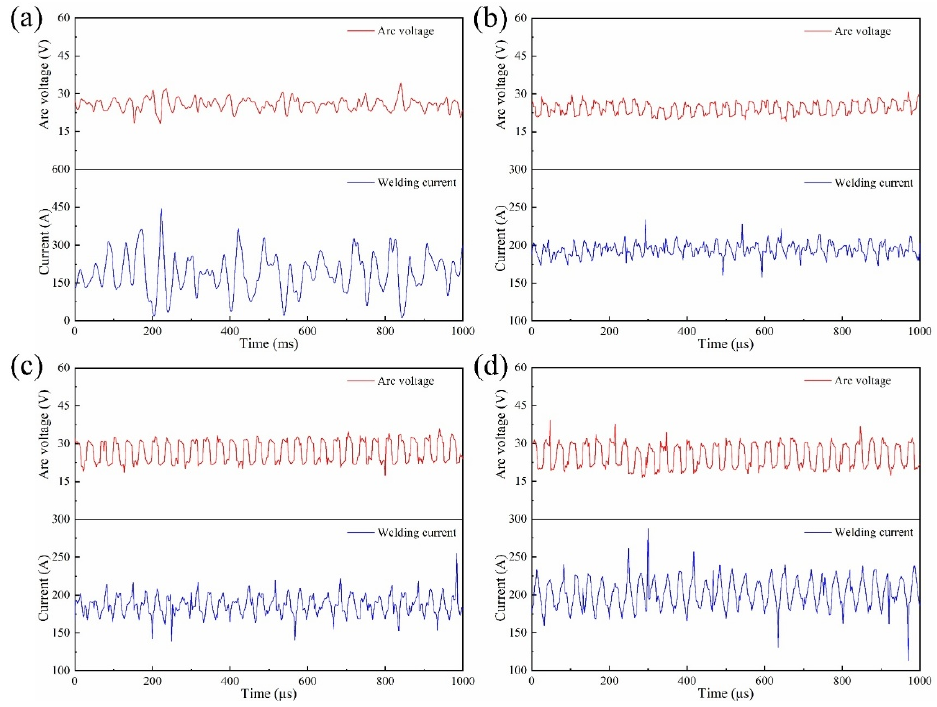
Figure 5. Arc voltage and welding current waveforms at different ultrasonic excitation voltages at an ultrasonic frequency of 30 kHz: ( a ) 0; ( b ) 20 V; ( c ) 40 V; ( d ) 60 V.